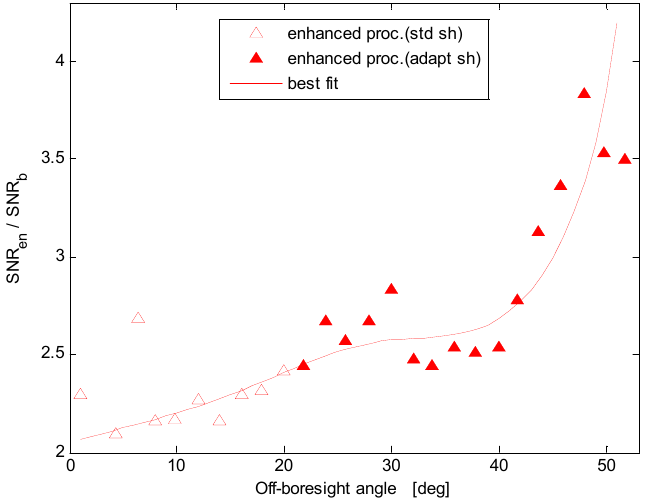
Figure 6. Ratio between the SNRs for the basic and enhanced